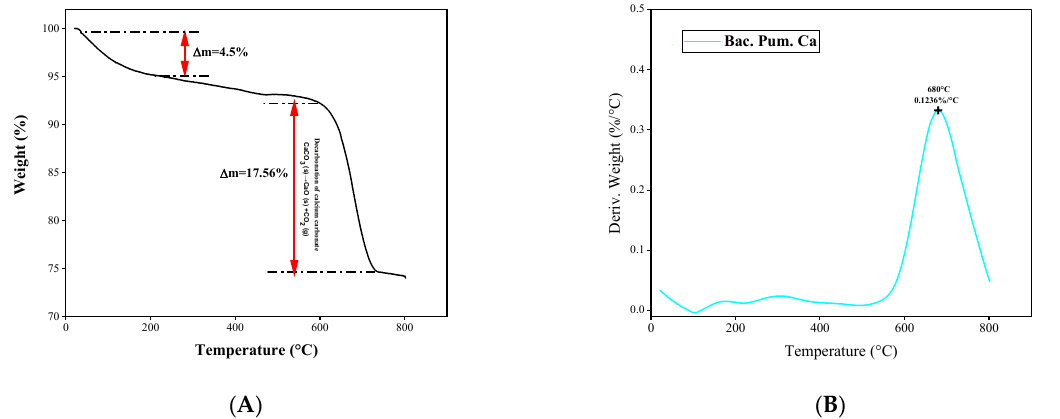
Figure 18. TGA plot of Healing product. ( A ) Weight loss versus Temperature, ( B ) derivative of weight loss versus temperature.